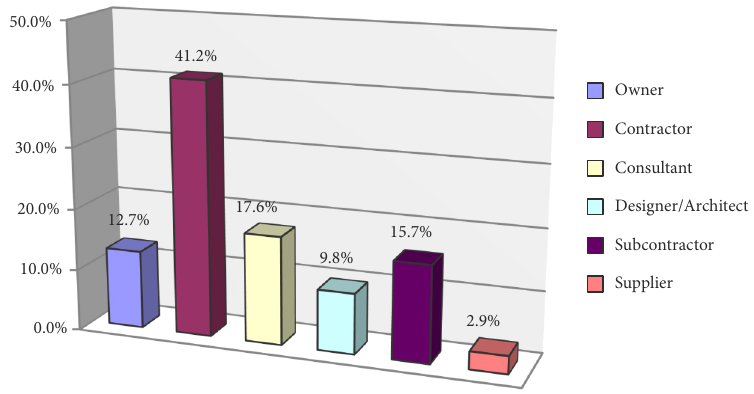
Figure 1. Percentage of respondents based on organization